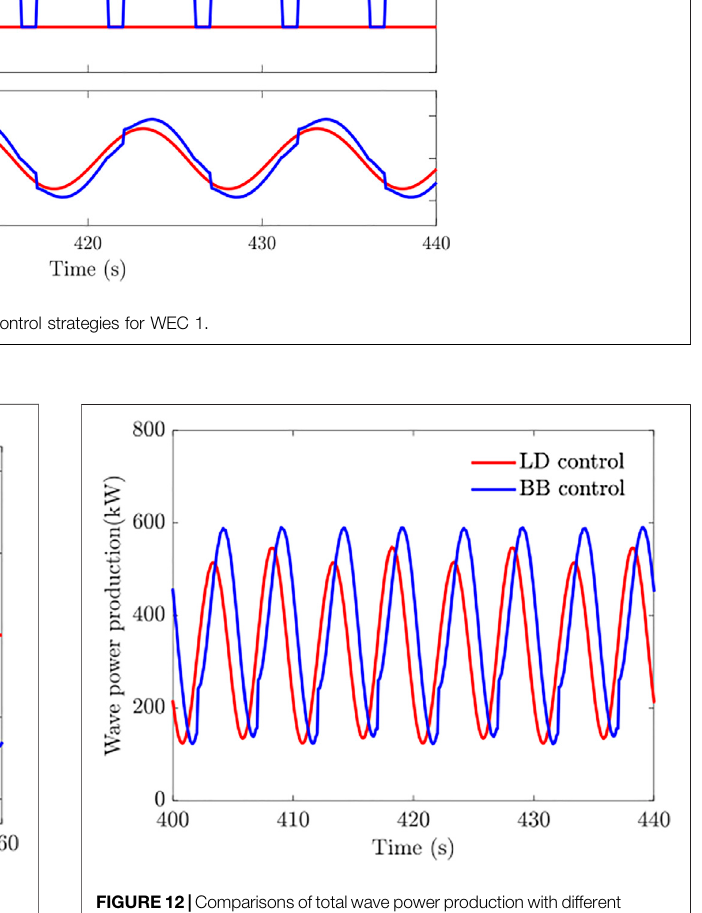
FIGURE 11 | Fender force between the platform and WEC 1 in the horizontal direction.